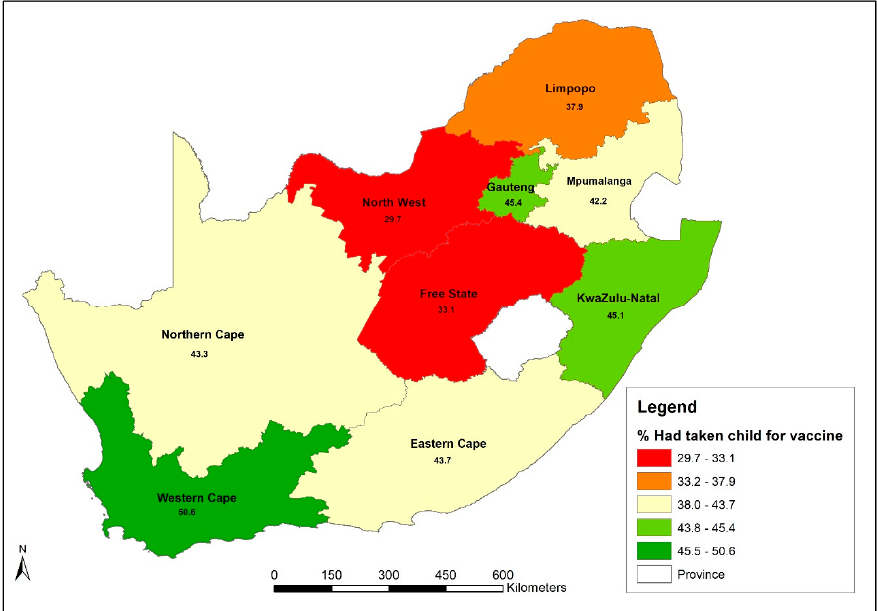
Figure 1. Map showing proportions of parents who took their children for scheduled vaccinations.